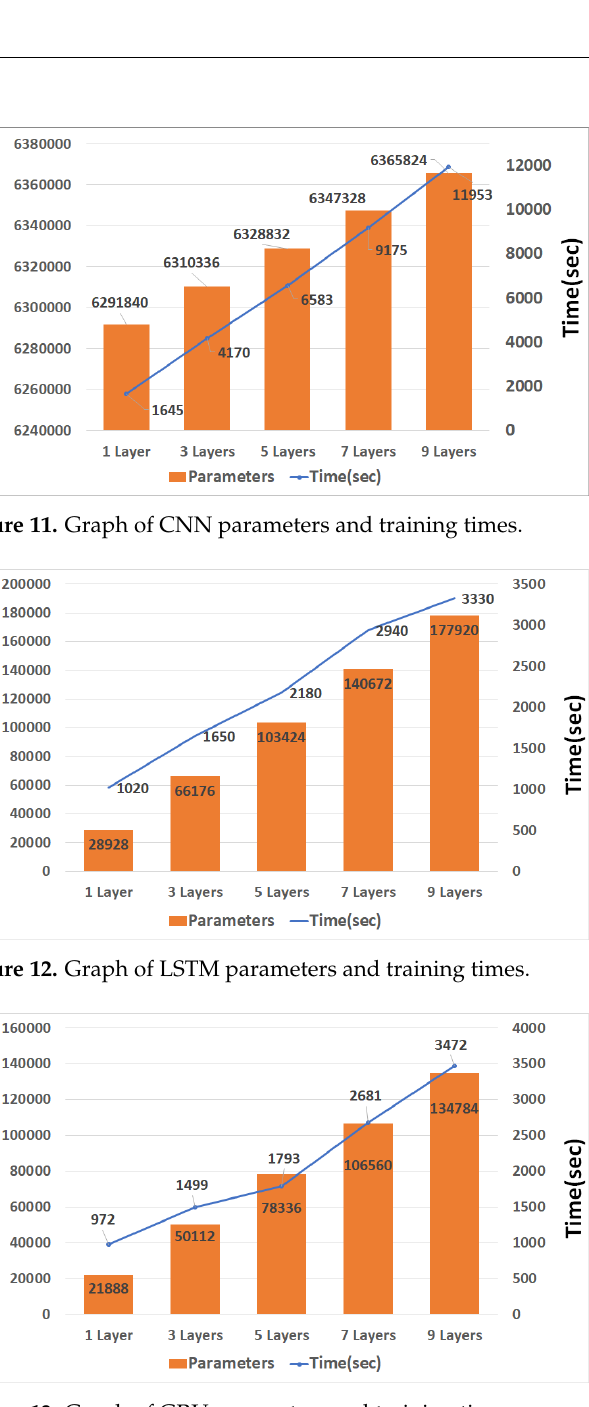
Figure 13. Graph of GRU parameters and training